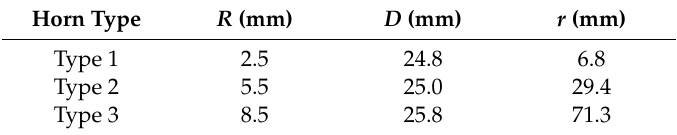
Table 1. Comparison-determined optimal dimensions for three horn